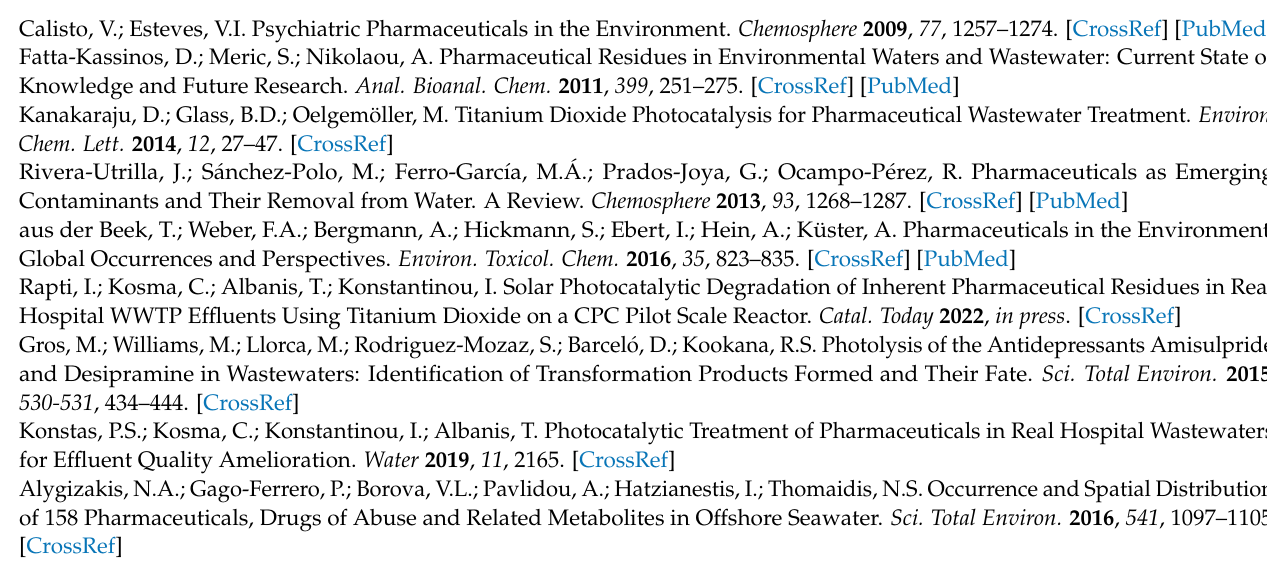
Figure S3: Effect of pH on the photocatalytic degradation of amisulpride in WW ([amisulpride] 0 = 1 mg L − 1 , [g-C 3 N 4 ] = 300 mg L − 1